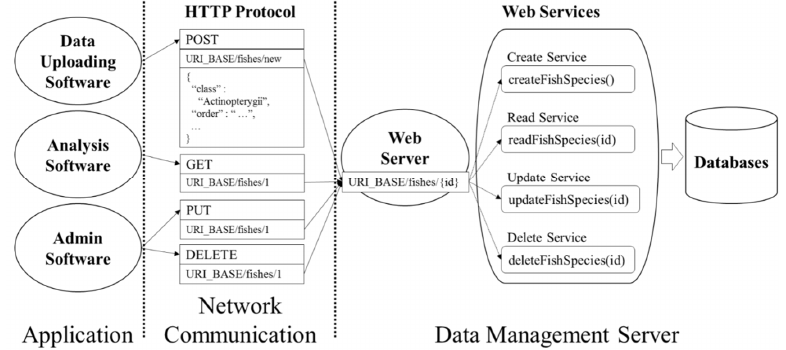
Figure 7. CRUD services for the fish instance resource.